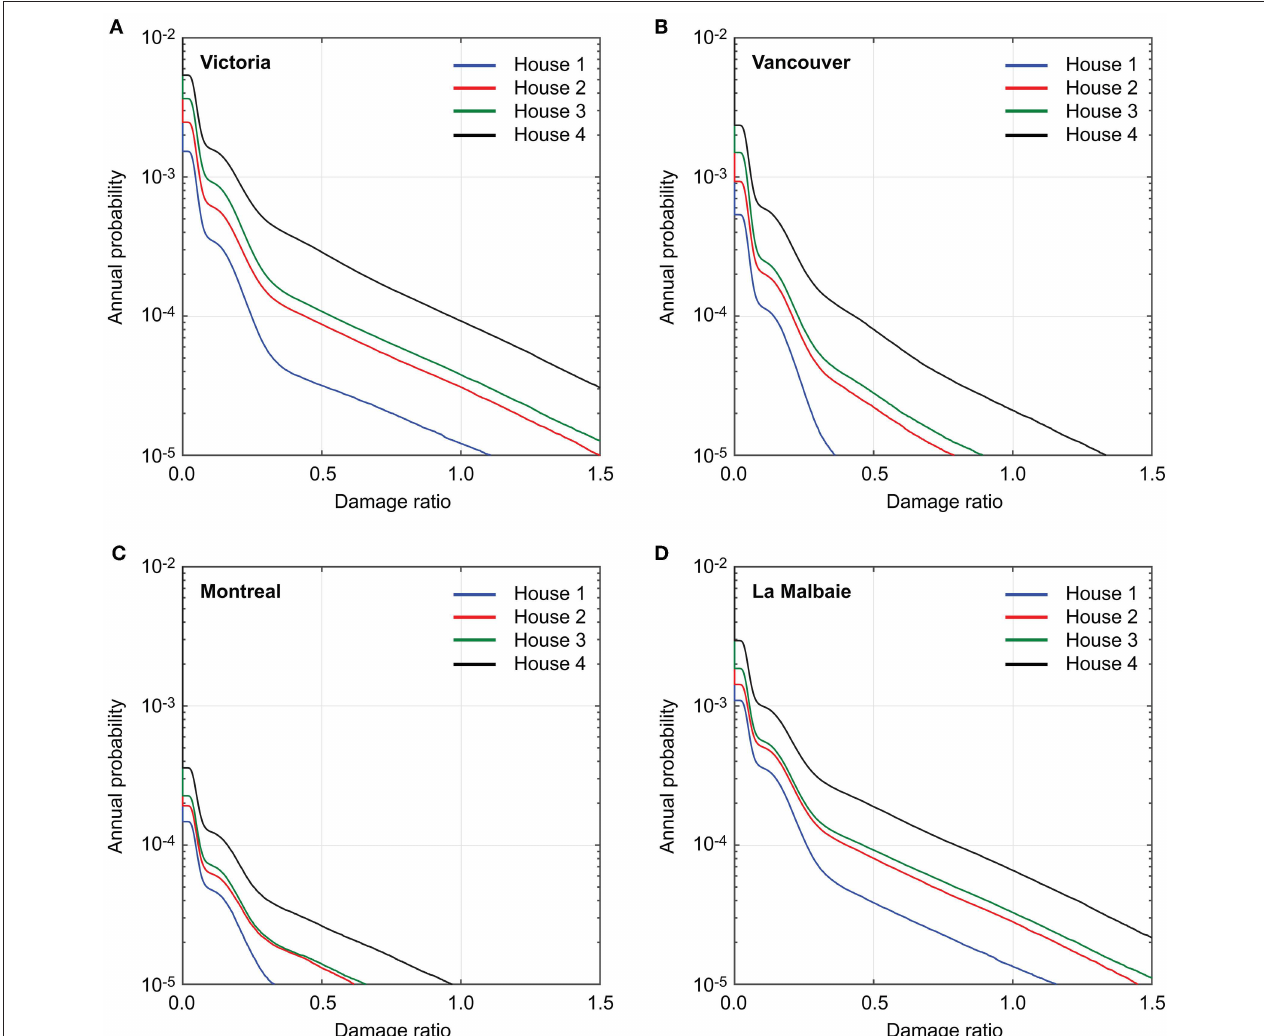
FIGURE 11 | Exceedance probability curves in terms of damage ratio for Houses 1 to 4: (A) Victoria, (B) Vancouver, (C) Montreal, and (D) La Malbaie.